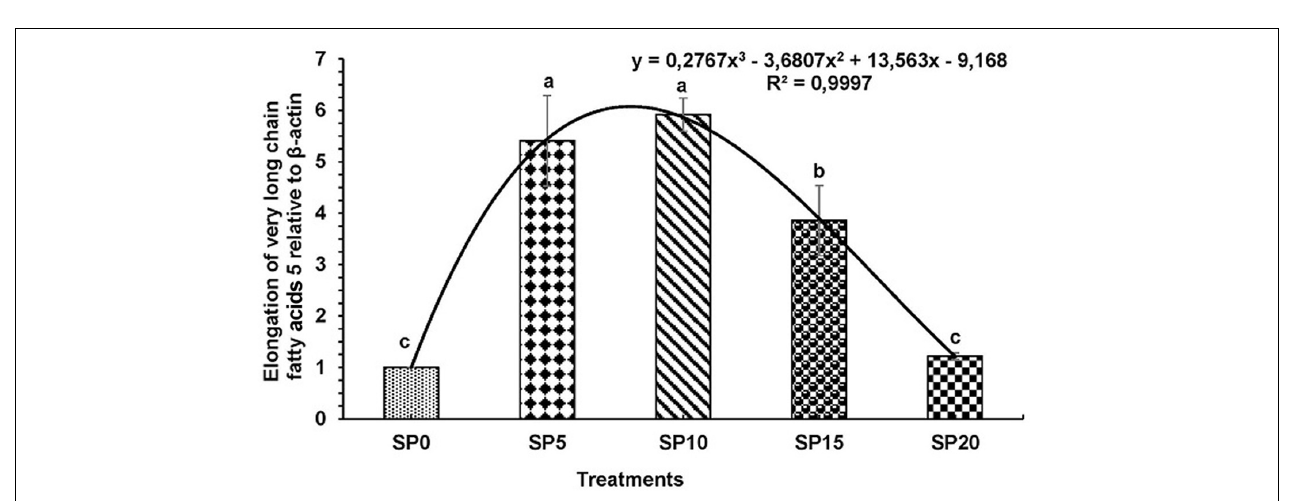
FIGURE 3 | Expression of elongation of very long chain fatty acids protein 5 ( elovl5 ) relative to β -actin in hepatopancreas of five different diet-fed Cyprinus carpio . Bars with different superscripts are significantly different ( n = 3). A polynomial (order 3) relationship was found between the diet and expression of fads2d6 ( R 2 =